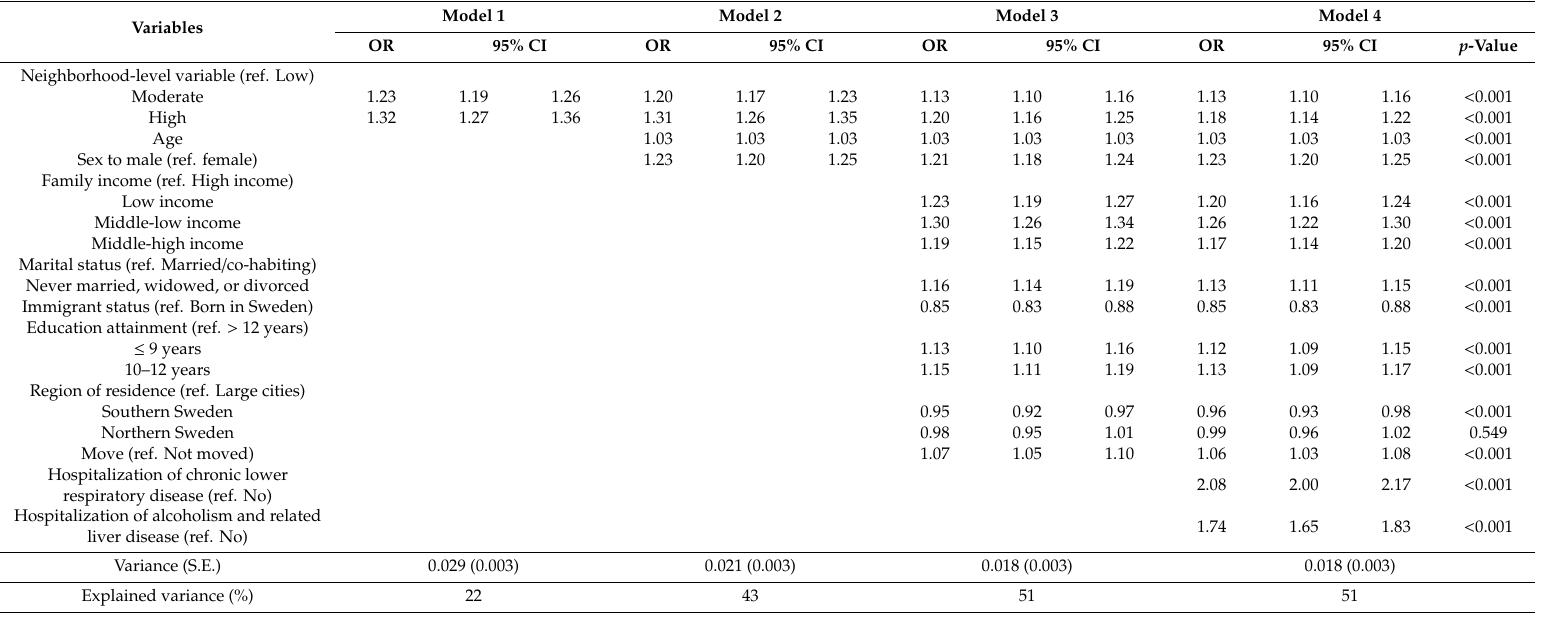
Explained variance